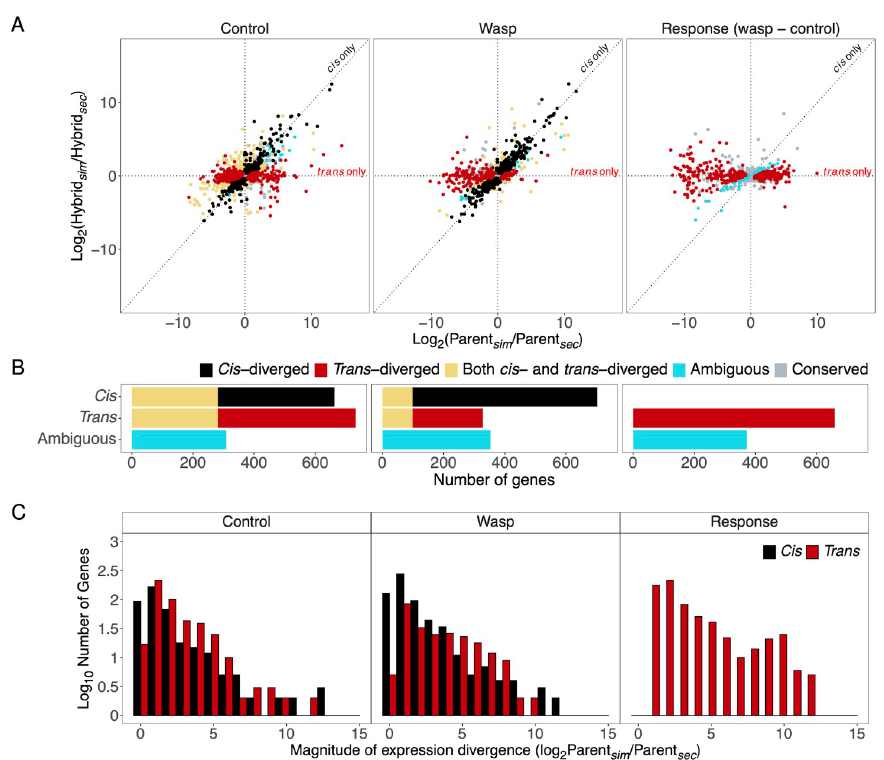
Fig 4. Expression divergence of immune responsive genes between D. simulans and D. sechellia in hemocytes. Plots only show genes that are significantly differentially expressed in response to infection in at least one species. (A) Expression differences between parental species (total regulatory divergence) plotted against allelic expression differences within F1 hybrids ( cis- regulatory divergence). Gene expression was measured under unchallenged control conditions (left) and immune-challenged conditions (centre), and this was used to estimate the expression change in response to immune challenge (right). Each point is a gene, the expression difference of each gene is represented as the relative log 2 fold change. (A and B) The genes are colour coded according to whether gene expression divergence is controlled in cis or in trans , with panel (B) depicting the number of genes in each category. The ambiguous category refers to genes with significant divergence in expression between the parental species but no significant divergence in either cis or trans . (C) Histograms depicting the frequencies of cis- and trans- diverged genes across the magnitudes of total expression divergence between D. simulans and D. sechellia . Fly larvae were immune-challenged by injecting them with oil droplets containing wasp homogenate.